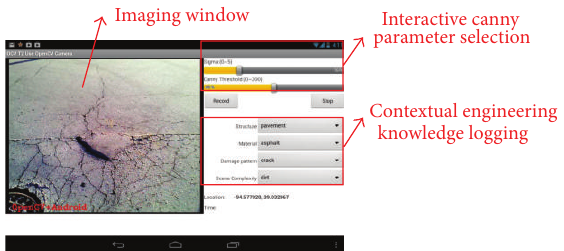
Figure 5: Mobile interface for contextual imaging of structural damage.